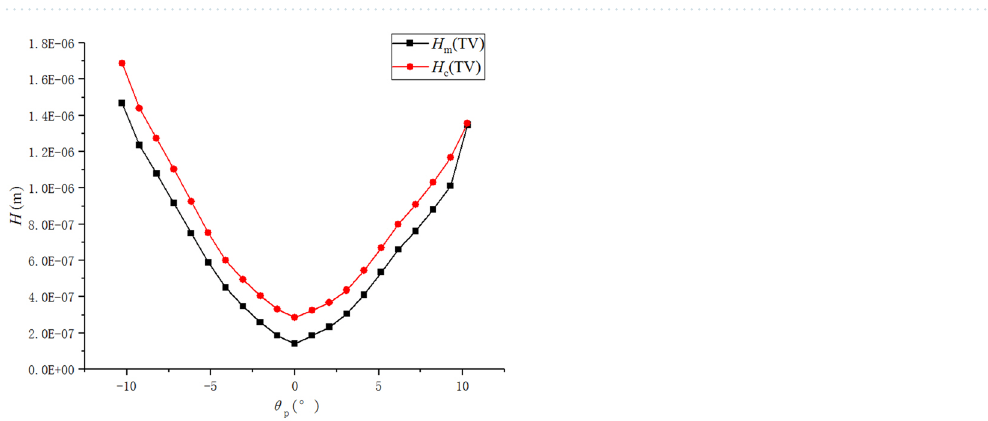
Figure 5. Oil film thickness distribution at different contact points.